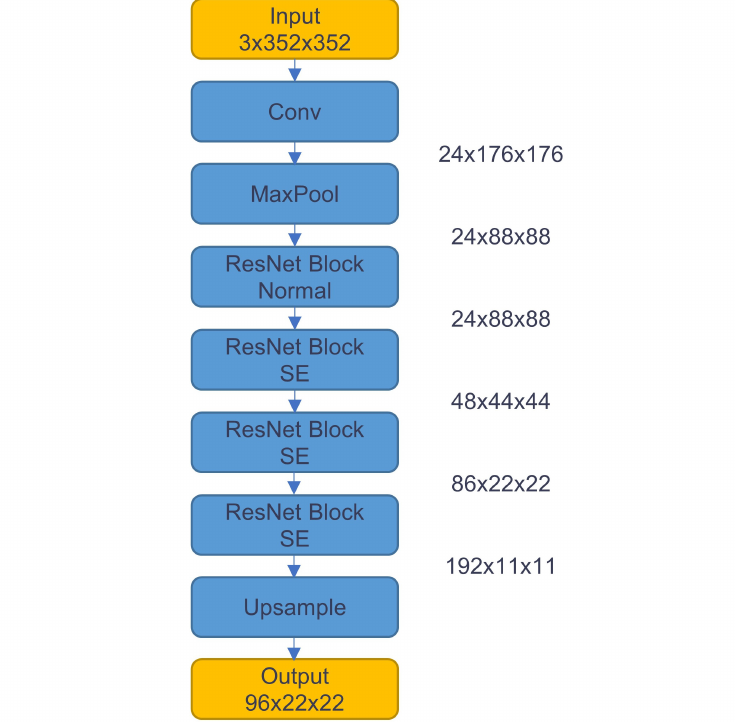
Figure 4. Overall backbone